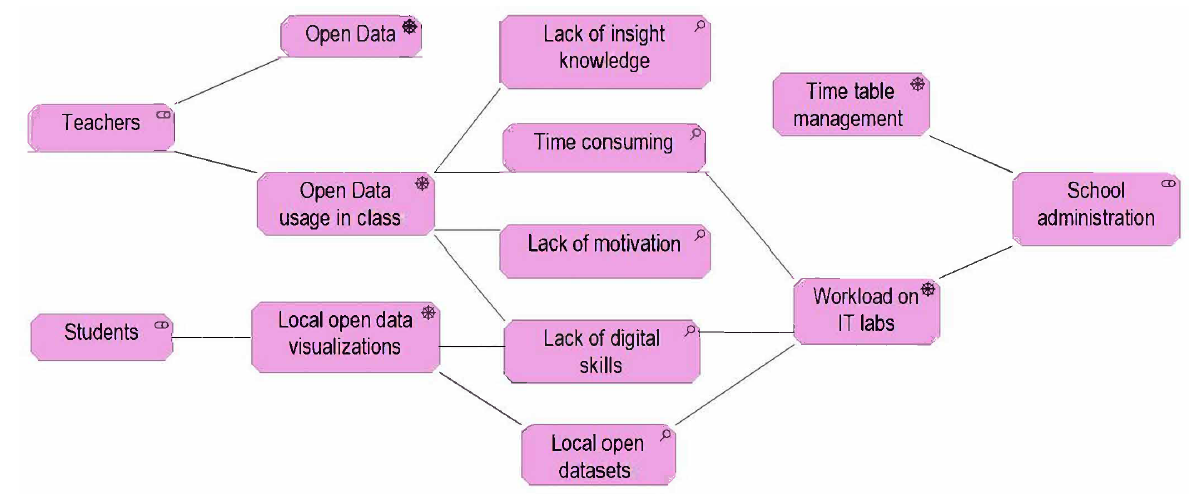
Figure 4. Stakeholder, concerns, and assessments